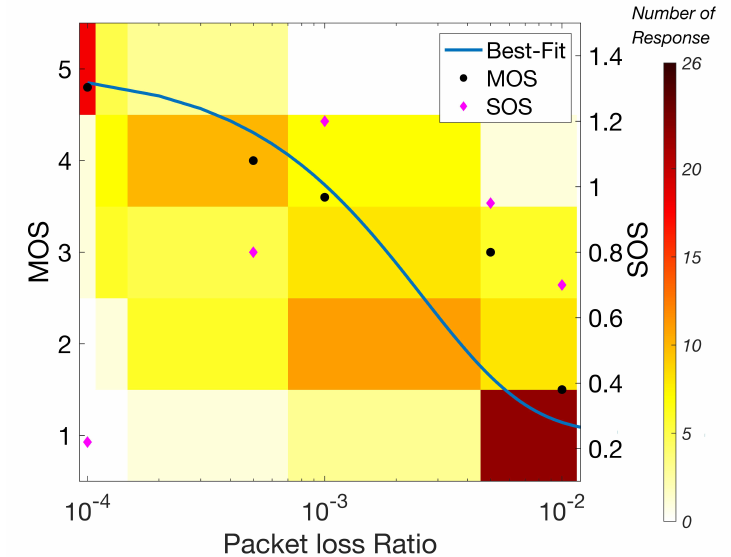
Figure 6. Heatmap of variation in perception of QoE of subjects at different PLR